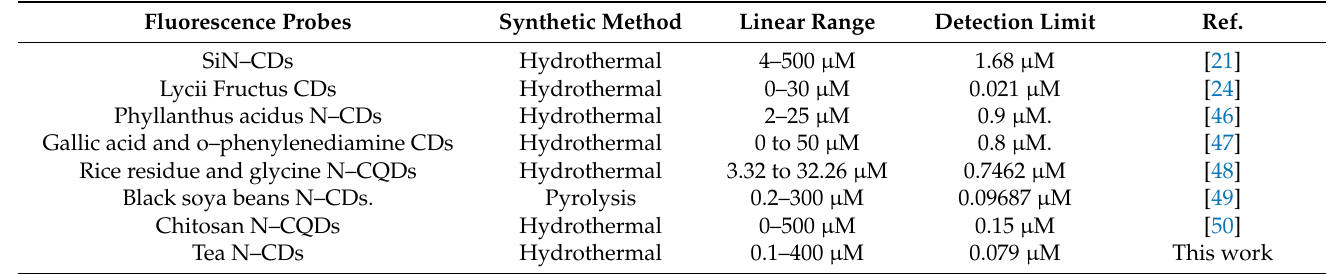
Table 1. Comparison of sensing performance of different CD–based fluorescent probes for Fe 3+ detection.